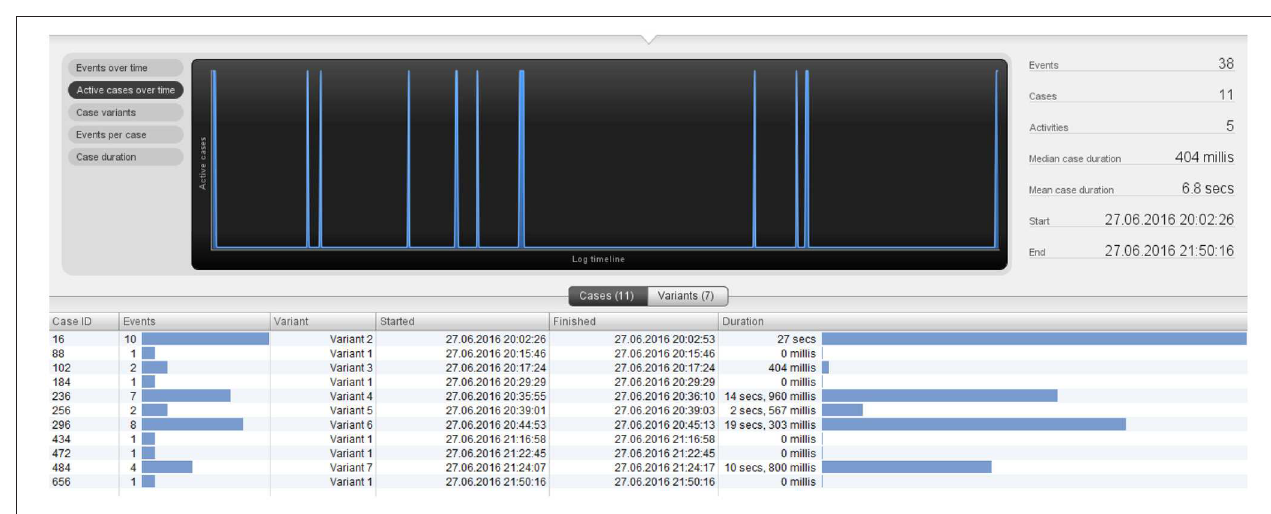
FIGURE 2 | Instances ending in a “miss” event for